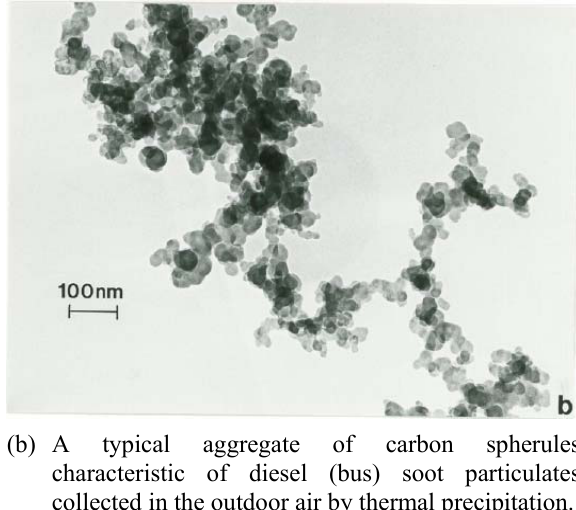
Figure 5: TEM bright-field image for black carbon (BC) (VULCAN-XC-72) (After Murr, et al. [17]).